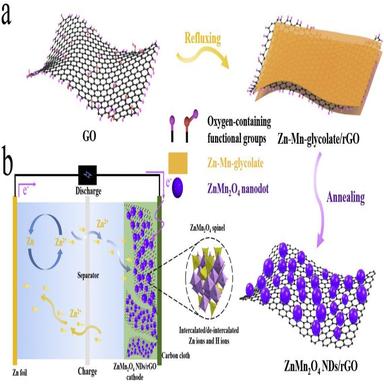
(a) Schematic illustration of the formation process of the strongly coupled ZnMn2O4 NDs/rGO composite and (b) the configuration of the Zn//ZnMn2O4 NDs/ rGO aqueous battery.